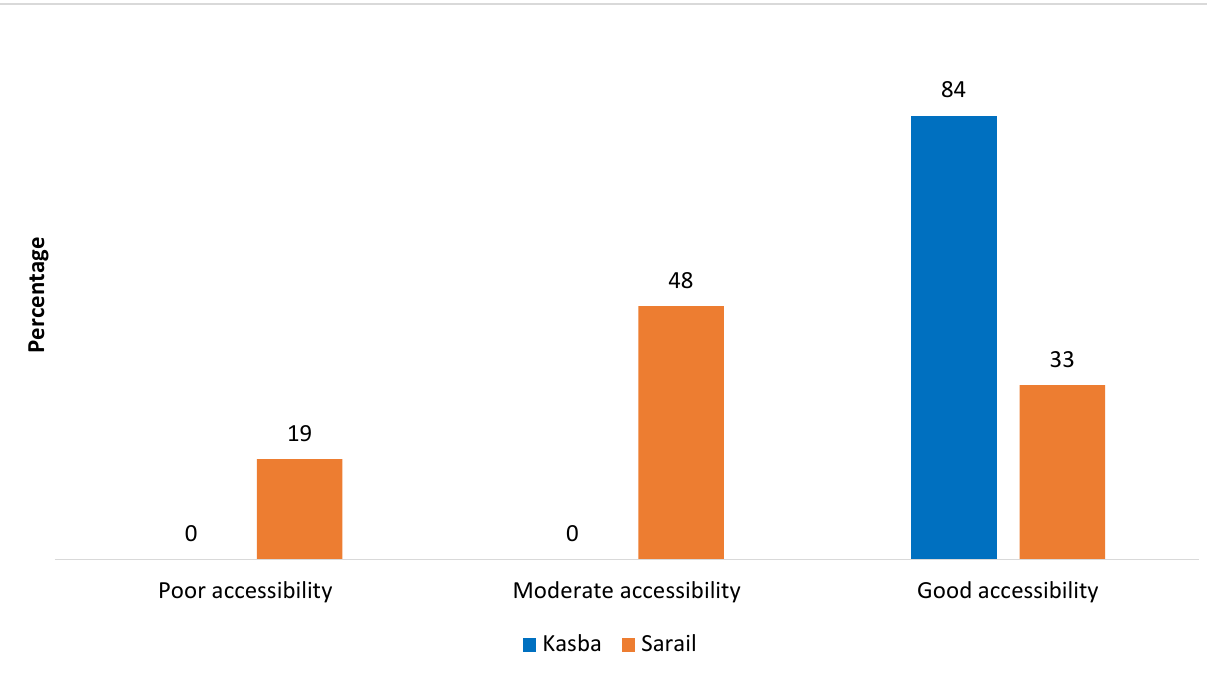
Figure 2. Accessibility status of CCs at Kasba (n = 33) and Sarail (n = 21). Data from 5/33 CCs were missing (staff absent in four CCs and one CC was destroyed).